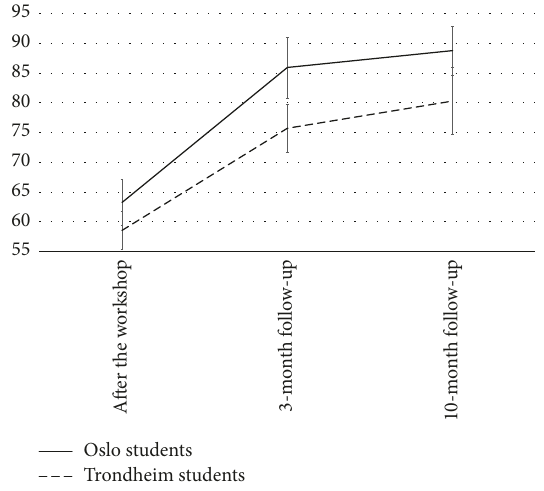
Figure2:Thecourseofself-efficacyforrecognizingclient’sinterper- sonal characteristics. Note . Score range is 12–120, and error bars are calculated by multiplying the standard error of the mean with 1.96. The total sample showed a linear increase in their N-SERIC scores across time, but also a quadratic trajectory (the flattening curves from 3-month to 10-month follow-up).